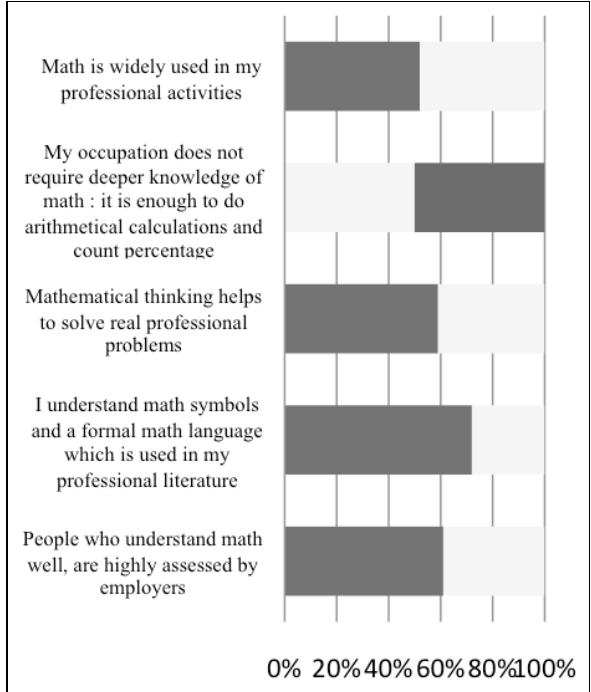
Figure 7. Mathematics in professional activities